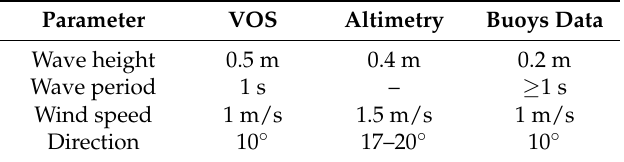
Table 1. Comparisons of resolution of VOS, altimetry, and buoys data (data provided by Grigorieva).